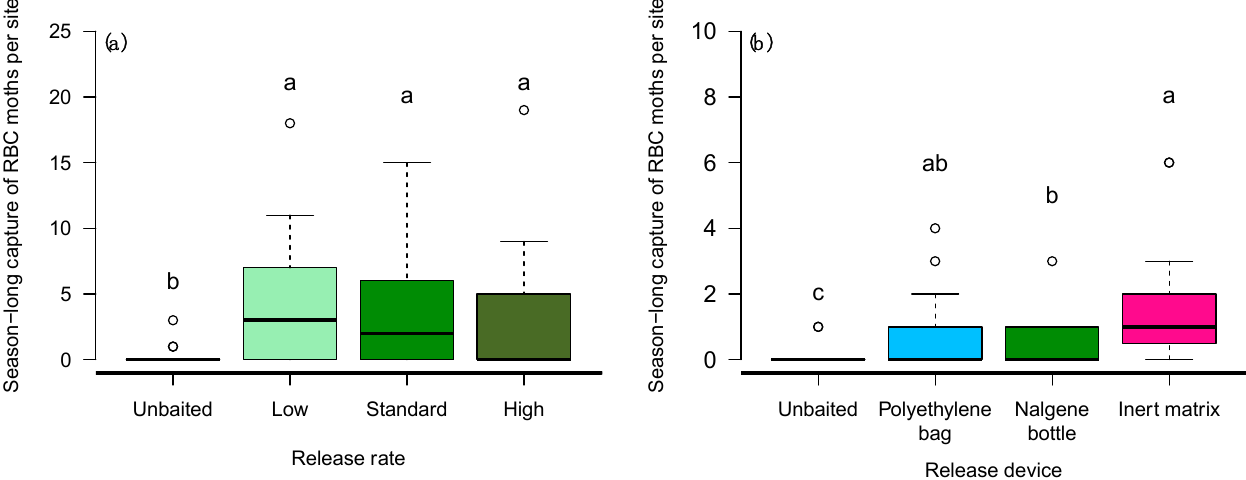
Figure 3. Box-and-whisker plots of the season-long capture of redbacked cutworm (RBC) moths in AAMB-baited traps at seven sites in central Alberta, Canada: ( a ) experiment 2—Different release rates manipulated by the diameter of holes drilled in the centre of the bottle cap: low (1.0 mm), standard (3.0 mm), high (5.0 mm) and an unbaited trap. ( b ) Experiment 3—AAMB lures from different release devices: Polyethylene bag, nalgene bottle, and inert matrix and an unbaited trap. Open circles represent points more than 1.5 times the interquartile range. Means comparisons were performed for differences in moth trap catch among treatments. Boxplots marked with different letters are statistically different (Tukey method, α = 0.05).